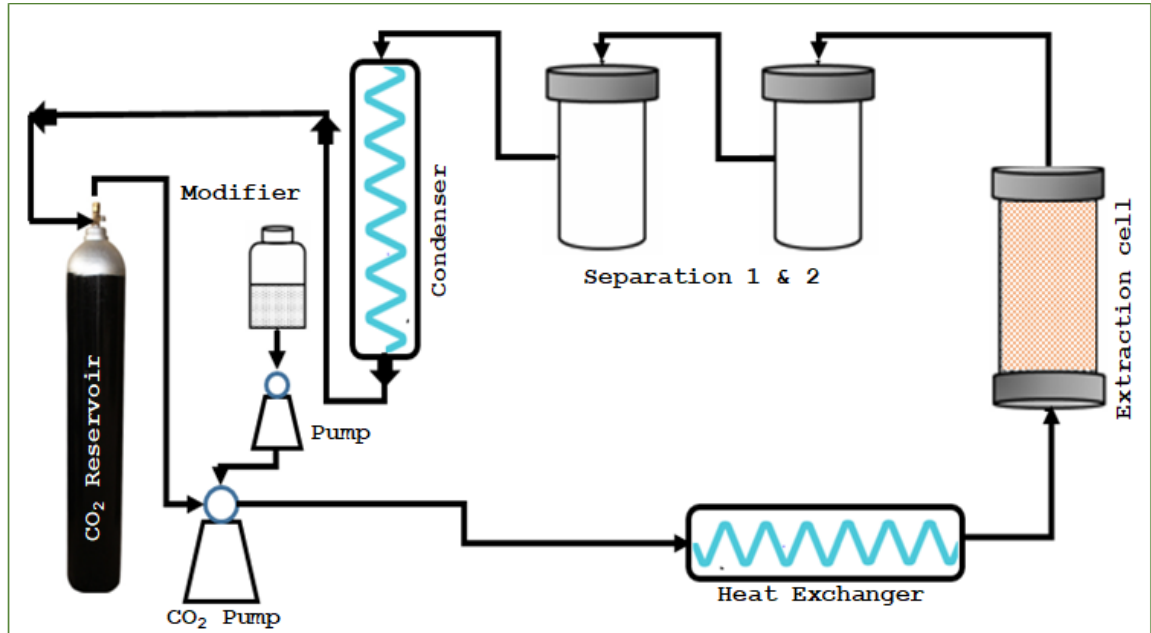
Figure 2. Illustrative diagram of supercritical fluid extraction